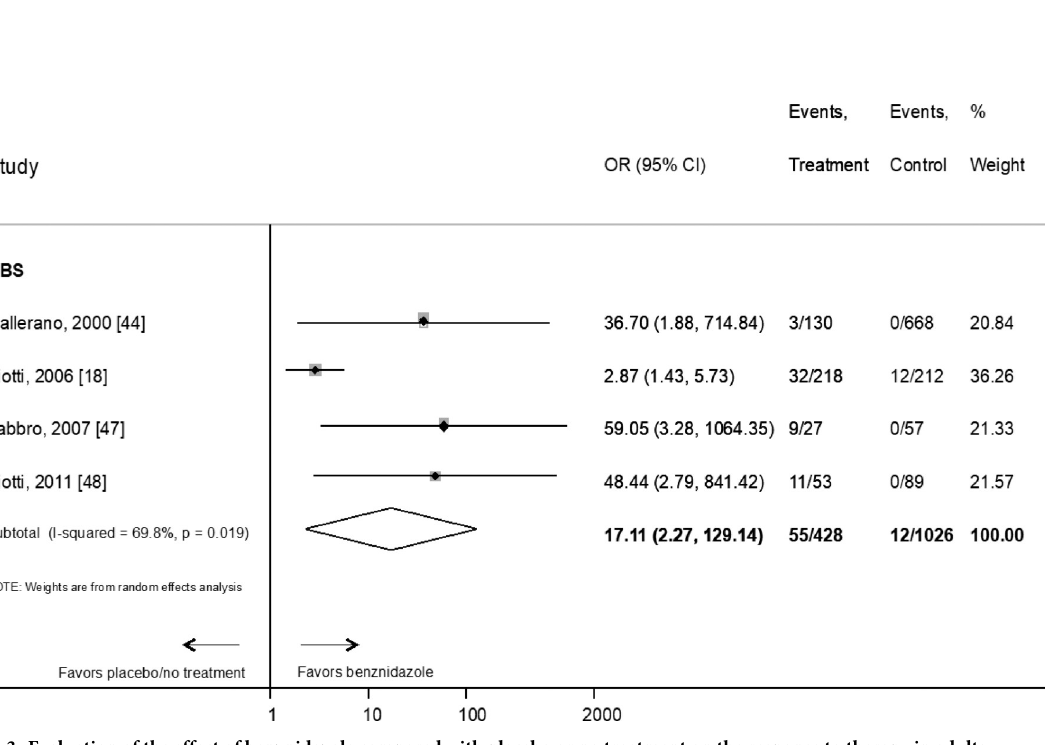
Fig 2. Evaluation of the effect of benznidazole compared with placebo or no treatment on the response to therapy in children according to serological primary endpoint by type of study. RCT: Randomized Clinical Trial; OBS: prospective observational study. References: [45], [38], [41].